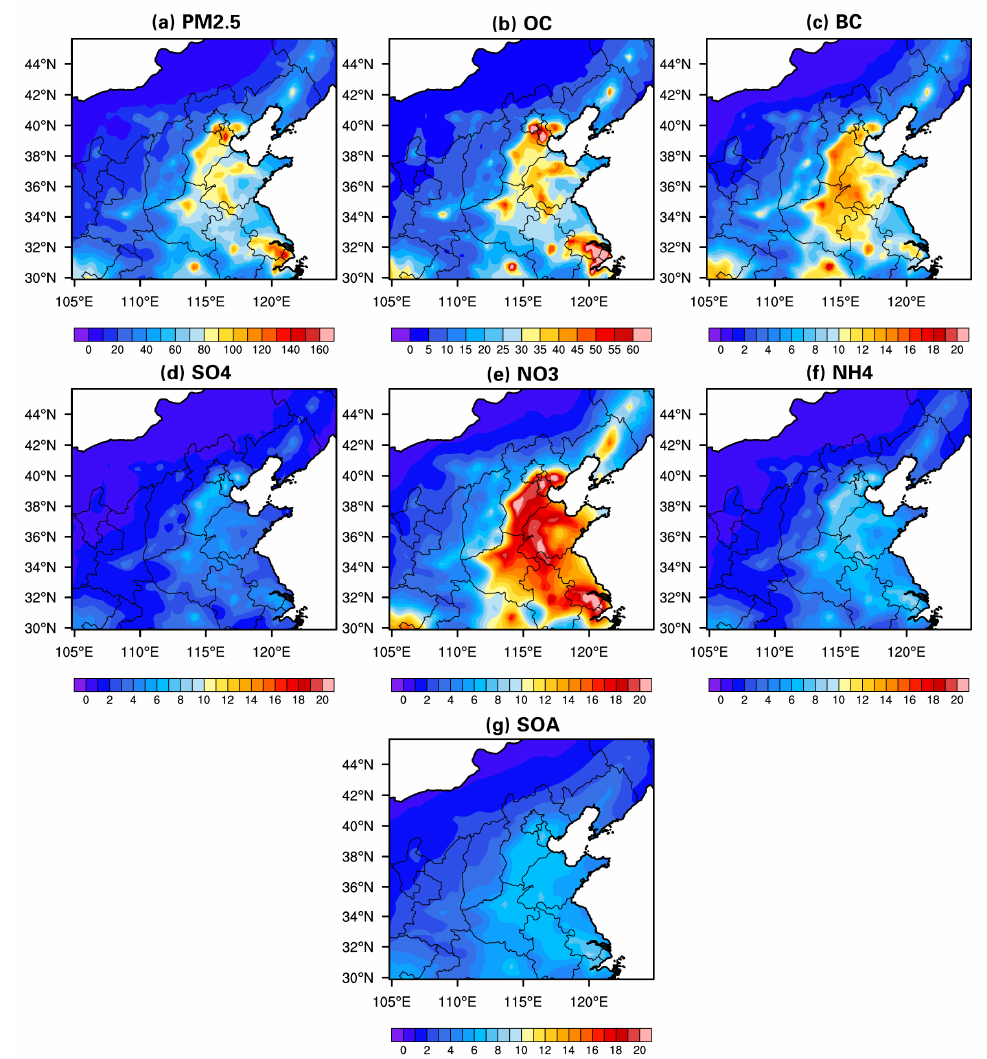
Remote Sens. 2021 , 13 , x FOR PEER REVIEW Figure 4. The year averaged surface concentration ( µ g · m − 3 ) of ( a ) PM 2.5 , ( b ) BC, ( c ) OC, ( d ) SO 4 , Figure 4. The year averaged surface concentration ( μg ∙ m − 3 ) of ( a ) PM 2.5 , ( b ) BC, ( c ) OC, ( d ) SO 4 , ( e ) NO 3 , ( f ) NH 4 , and ( g ) SOA in 1986–2005. ( e ) NO 3 , ( f ) NH 4 , and ( g ) SOA in 1986–2005.